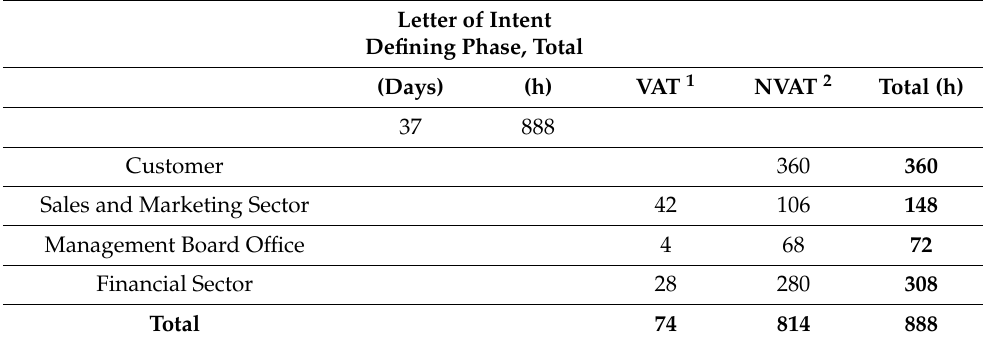
Table A8. The average durations of the Letter of Intent defining phase activities—the future state.